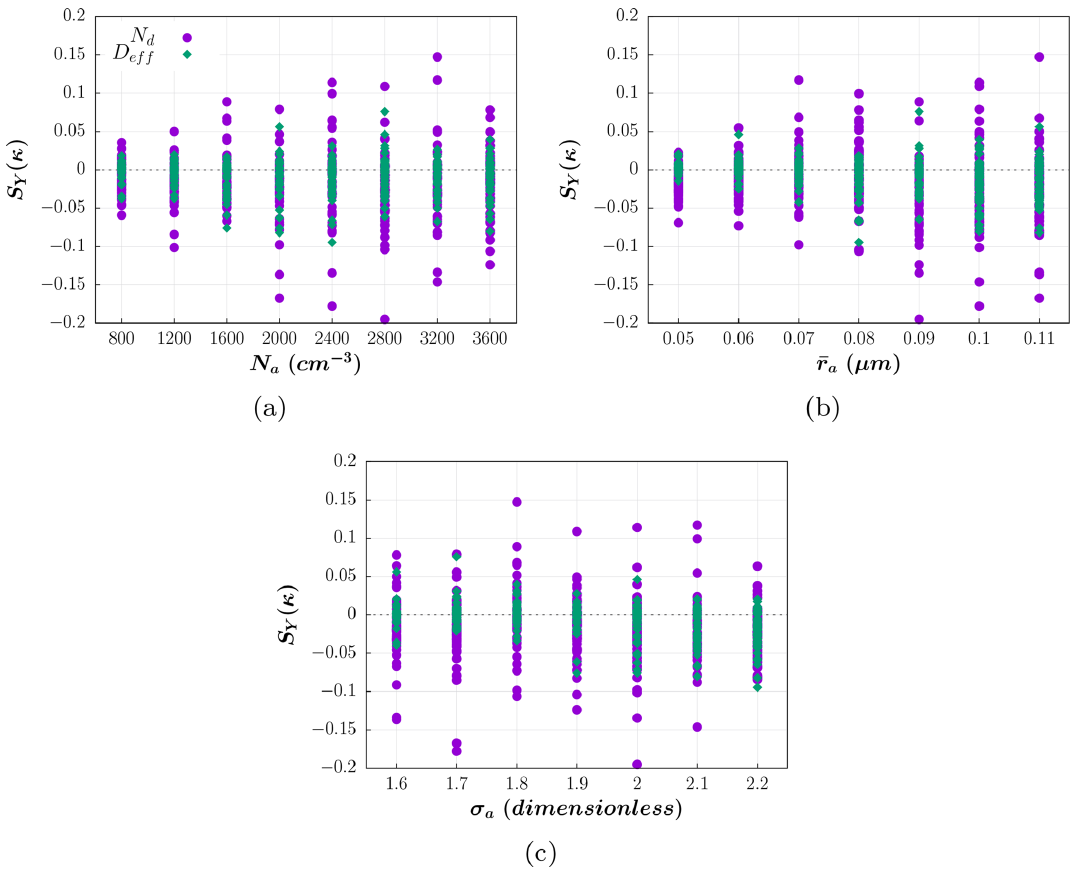
Figure 7. Sensitivities of the droplet number concentration and effective diameter to the aerosol hygroscopicity, S Y (κ) , as a function of (a) the aerosol number concentration ( cm − 3 ), (b) the median radius of the PSD (µm) and (c) the geometric standard deviation of the PSD